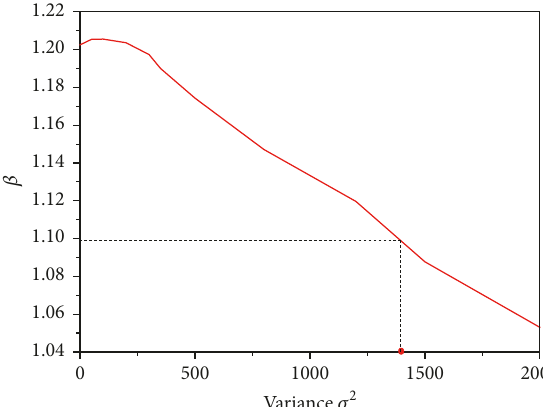
Figure 13: Relationship between the isotropic factor 𝛽 and variances 𝜎 2 for a rubber composite reinforced with aramid fibers: 𝑙 f =1.5 mm, V f